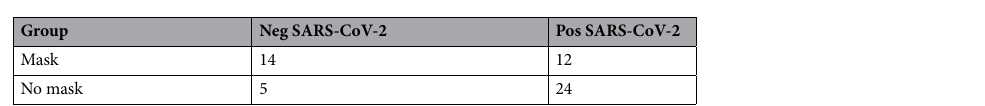
Figure 1. Sports facility and its zones according to the health and safety/hygiene concept implemented by the 2. Basketball Bundesliga (not true to scale). Group